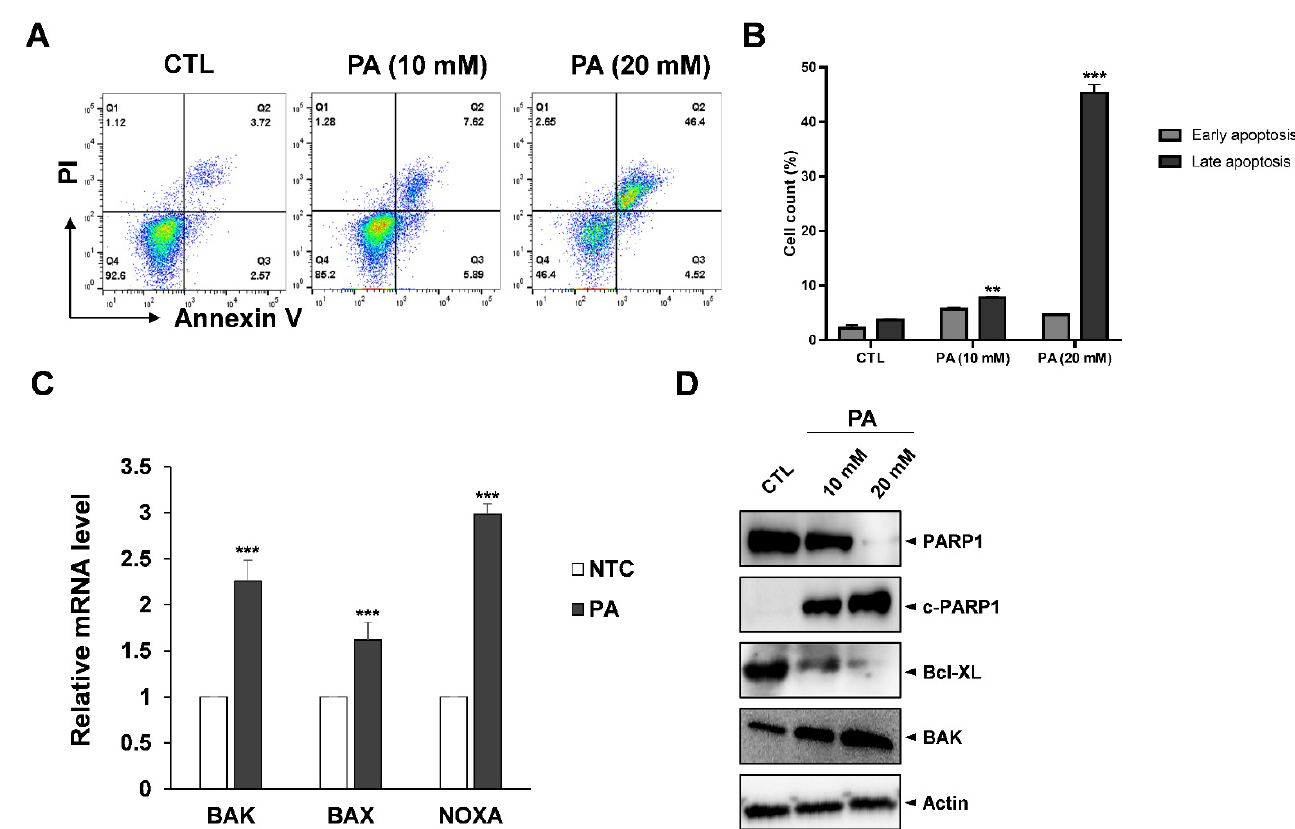
Figure 2. PA-induced apoptosis in HeLa cells. ( A ) Apoptosis population after treating HeLa cells with PA for 48 h. The cells were harvested, stained with PI and Annexin V, and then measured by flow cytometry. ( B ) Quantification of the early and late apoptosis populations. ( C ) RT-PCR results with apoptotic markers such as BAK, BAX and NOXA and normalized by actin. ( D ) Protein expression of cleaved PARP1, PARP1, BAK, and BCL-XL as examined by Western blot analysis. Values indicate means ± SEM. ( n = 3, ** p ≤ 0.01, *** p ≤ 0.001). pathway of apoptosis. The family includes three subclasses: the proapoptotic BH3-only